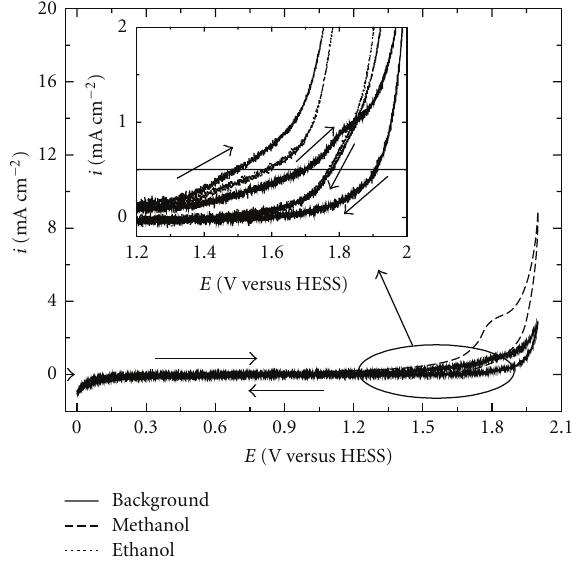
Figure 11: Comparative voltammetric study (first cycle) for the oxidation of methanol (dashed line) and ethanol (dotted line) in 0.5M H 2 SO 4 and background responses in the supporting elec- trolyte (solid line), recorded used a nonmodified BDD electrode, ν = 5mVs − 1 (reprinted with permission from [61]).